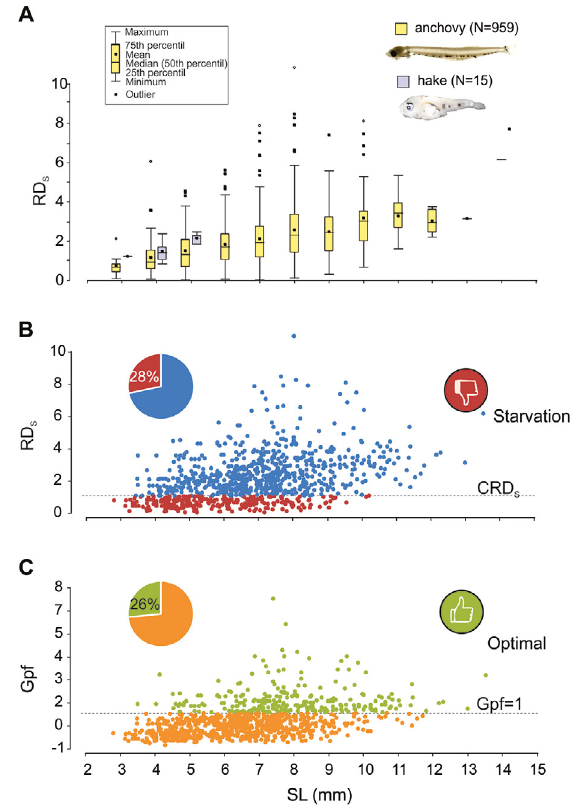
Fig. 3. – (A) Box plot of the standardized RD index as a function of standard length (SL, mm) class for larvae of anchovy Engraulis anchoita and hake Merluccius hubbsi . Dispersion graph of the (B) standardized RNA/DNA index (RD) and (C) growth performance (Gpf) as a function of the SL of larvae of anchovy Engraulis anchoita . The dotted line in (B) indicates the critical value of the RD index (CRD), the individuals in starvation (RD<CRD) are indicated in red, and the individuals in good nutritional condition are indicated in blue. The dotted line in (C) indicates optimal growth performance (Gpf=1); the individuals in optimal growth (Gpf>1) are indicated in green, and the individuals that showed less than optimal growth are shown in